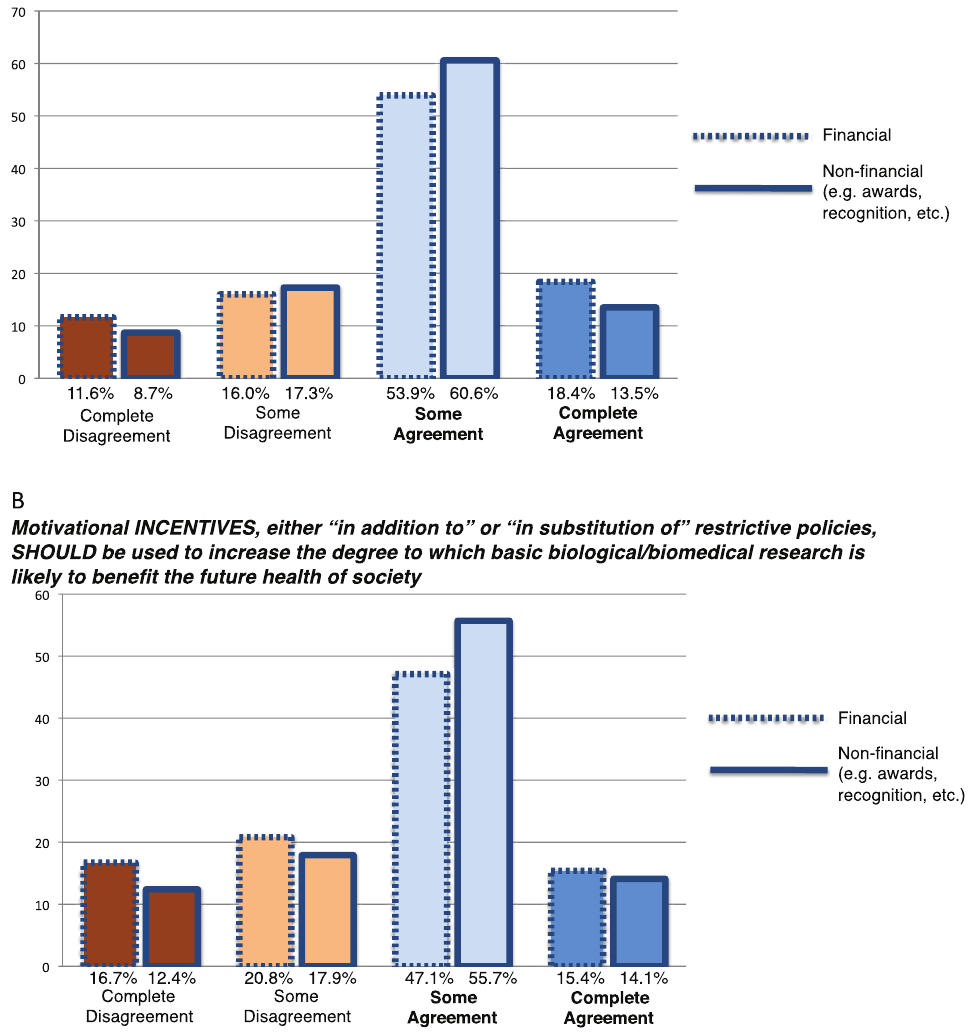
Figure 7. Most scientists are in favor of motivational incentives to increase the health benefit potential of their investigations. ( A ) Graph shows the levels of agreement on the following statement: “Motivational INCENTIVES, which are not based on restrictive policies such as the requirement to discuss the potential of future health benefits, CAN increase the degree to which basic biological/biomedical research is likely to benefit the future health of society”. 293 answered the question; 11 skipped. The incentives were proposed either as financial or as non-financial. ( B ) Graph shows the levels of agreement on the following statement: “Motivational INCENTIVES, either “in addition to” or “in substitution of” restrictive policies, SHOULD be used to increase the degree to which basic biological/biomedical research is likely to benefit the future health of society”. 294 answered the question; 10 skipped. The incentives were proposed either as financial or as